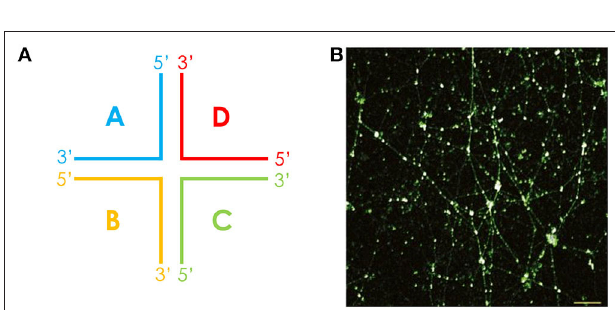
FIGURE 3 | The eDNA lattice within biofilms is structurally related to a Holliday junction. (A) The cruciform-like structure of a Holliday junction, consisting of four double-stranded DNA arms that are joined. The Holliday junction may also adopt alternative conformations. (B) These structures were first observed in a chinchilla middle ear infected with NTHI, where cruciform DNA structures were stained in white and dsDNA in green. Scale bar, 10 µ m. Reproduced from [